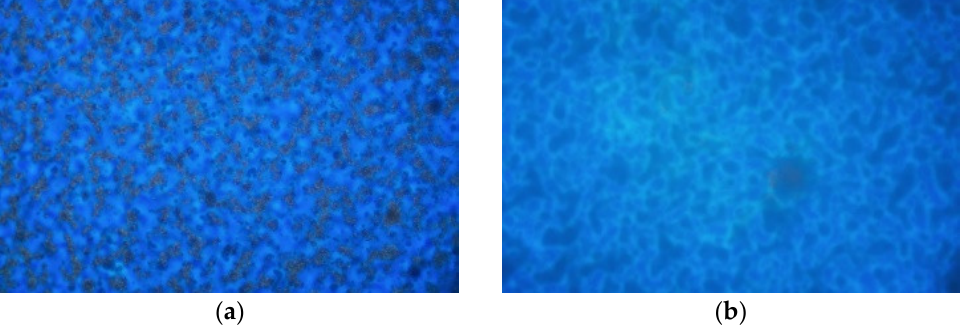
Figure 13. Fluorescent micro-structure of WE/A with 40% WER ( a ) 1 h; ( b ) 48